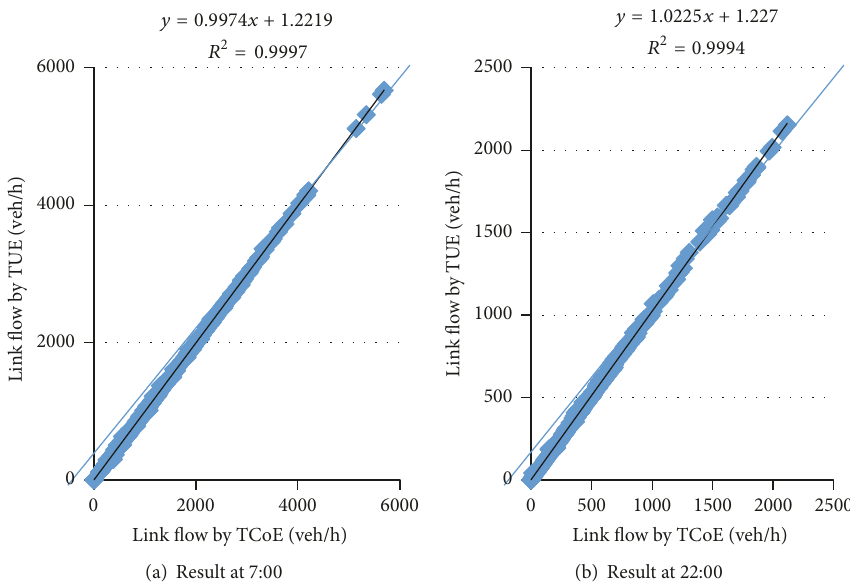
Figure 10: Comparison between results by the TCoE and the TUE with OD-dep from TCoE.